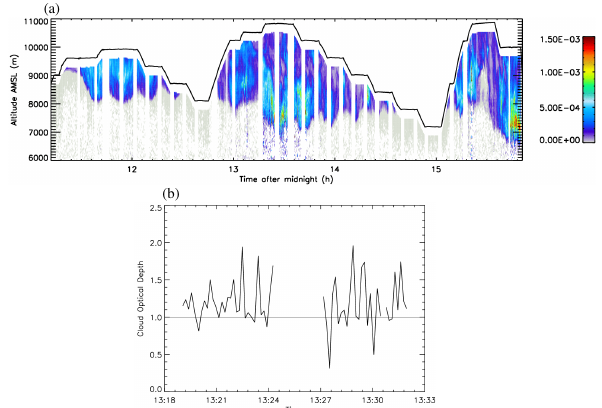
Figure 7. (a) The lidar-derived cloud volume extinction coefficient as a function of altitude (m) and time in units of hours after mid- night (UTC). The colour bar on the right-hand side of the figure indicates values of the cloud volume extinction coefficient in units of m − 1 , and the solid line represents the aircraft altitude. (b) The lidar-derived cloud optical depth from 300m below the aircraft to the cloud base as a function of UTC time, and the horizontal solid line shown in the figure indicates an optical depth value of